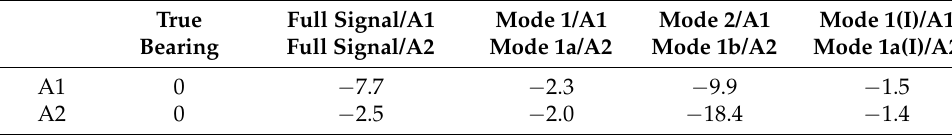
Figure 5. ( a ) Estimation results of the source bearing at point A1, with array L1, using the full signal, mode 1, mode 2, and the first packet signal of mode 1; ( b ) a zooming-in of the area enclosed by the dashed square in ( a ). The true azimuth of the sound source is indicated by the black vertical solid arrow. Table 1. Bearing estimation results using full modes or individual modes at A1 and